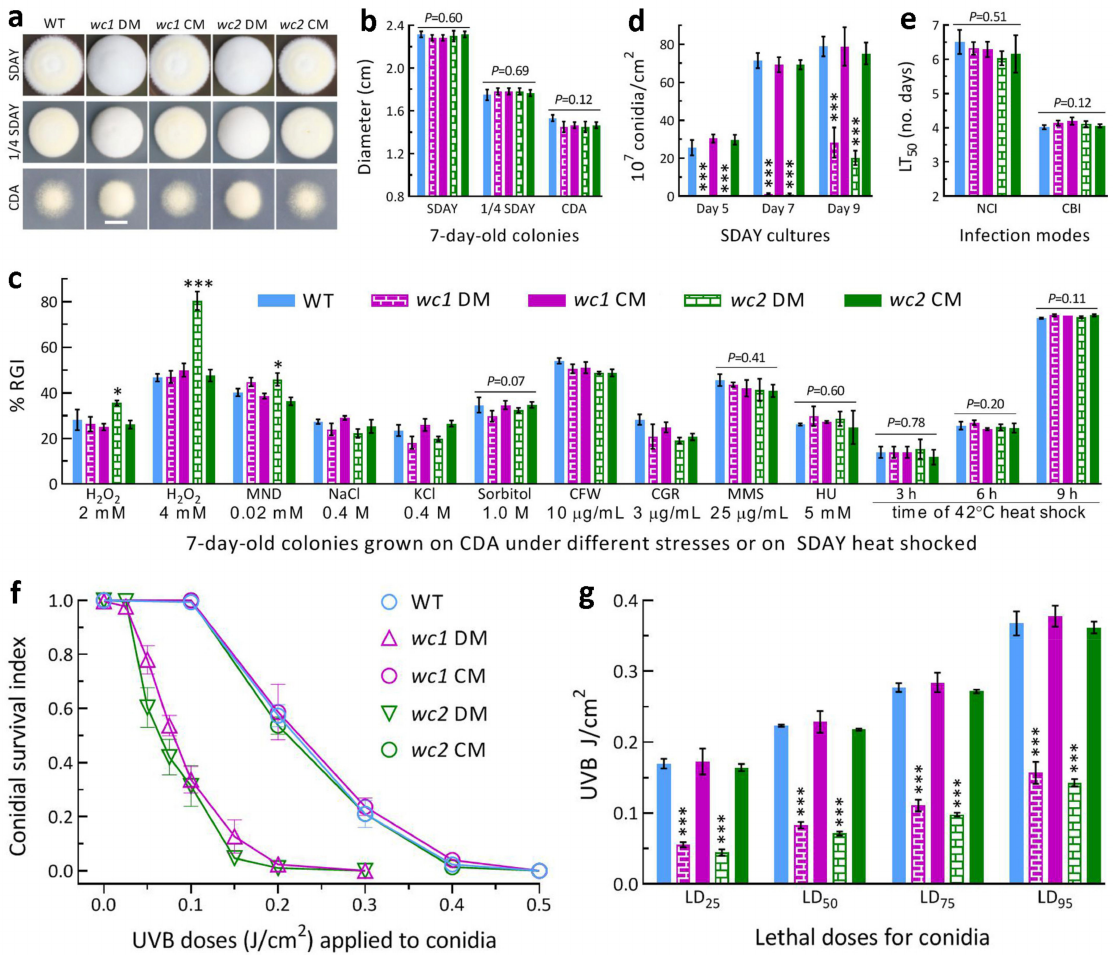
Figure 1. Roles of WC1 and WC2 in the lifecycles in vitro and in vivo of B. bassiana . ( a , b ) Colony images (scale: 10 mm) and diameters of fungal strains (WT, wild-type; DM, disruption mutant; CM, complemented mutant) incubated on SDAY, 1/4 SDAY, and CDA for 7 days at the optimal regime of 25 ◦ C and 12:12 (L:D). ( c ) Relative growth inhibition (RGI) of fungal colonies incubated at 25 ◦ C for 7 days on CDA supplemented with indicated concentrations of different chemicals (MND, menadione; CFW, calcofluor white; CGR, Congo red; MMS, methyl methanesulfonate; HU, hydroxyurea) and on SDAY for 5-day growth recovery after 2-day-old colonies were exposed to 42 ◦ C for 3, 6, and 9 h of heat shock. Each colony was initiated with ~10 3 conidia. ( d ) Conidial yields in the SDAY cultures incubated at the optimal regimes for 5, 7, and 9 days after initiation by spreading 100 µ L aliquots of a 10 7 conidia/mL suspension. ( e ) LT 50 for the virulence of each strain against G. mellonella larvae via normal cuticle infection (NCI) and cuticle-bypassing infection (CBI). ( f , g ) Conidia survival trends over the gradient UVB doses and lethal doses (LD x ) estimated from the trends using modeling analysis. p < 0.05 * or 0.001 *** in Tukey’s test. Error bars: standard deviations (SDs) of the means from three independent